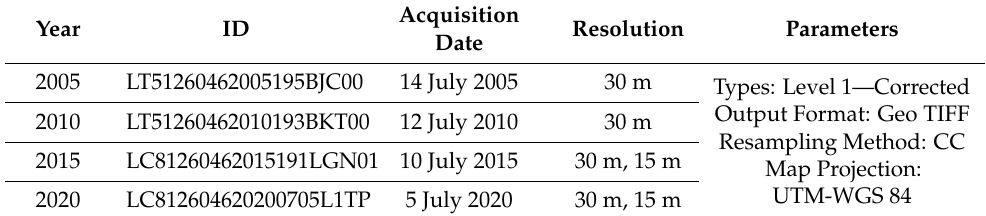
Table 1. Landsat